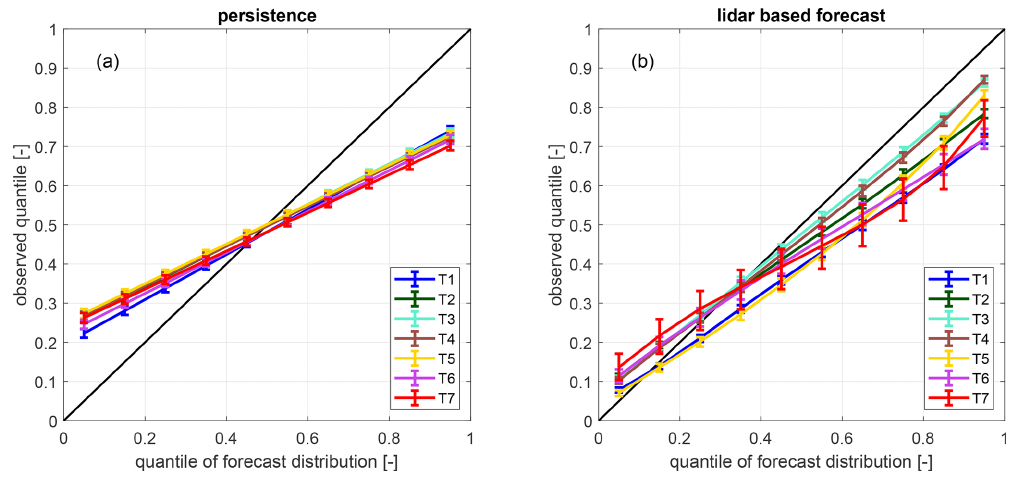
Figure 13. An example 1.5h time series of the 5min ahead lidar power forecast for unstable stratification at turbine T3 shown in red. Confidence intervals are visualized as shaded grey areas from 5% to 95% in 10% intervals. The blue curve shows 1min mean SCADA data of T3 and the green curve persistence.